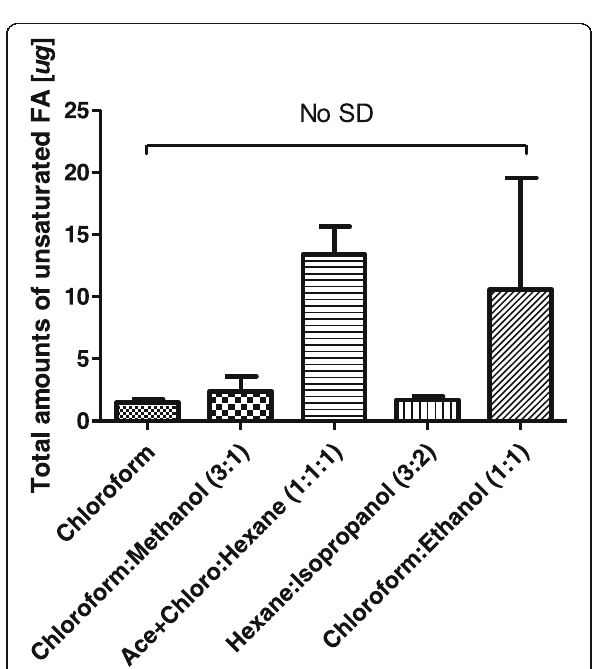
Fig. 6 Total quantity of unsaturated fatty acids by using different organic solvents ( μ g of total fatty acids). “ No SD ” means there is no significant difference ( n = 10, all